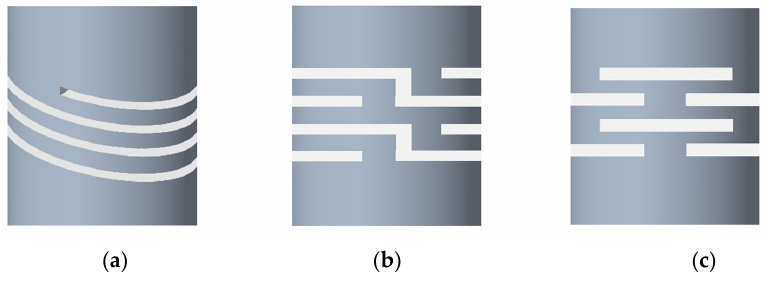
Figure 4. Three slotted designs for sensors. ( a ) Coil spring design; ( b ) cantilever beam design; ( c ) parallel slot design.